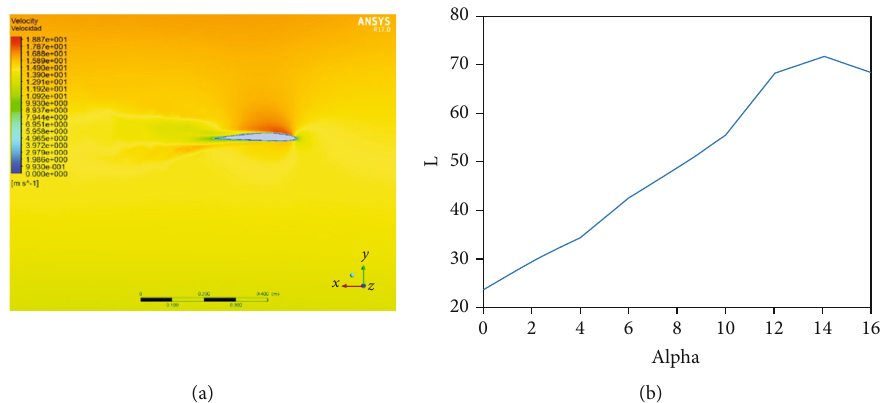
Figure 15: (a) Air velocity over the wing. (b) Lift produced by the wing.